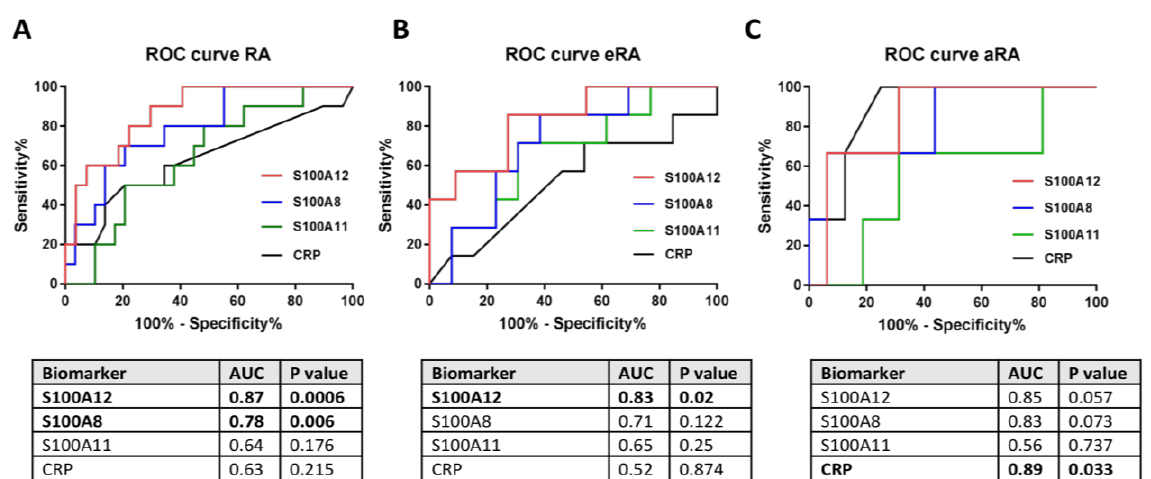
Figure 5. Receiver operating characteristic (ROC) curves for S100A8, S100A11, S100A12, and CRP in the sera of RA patients: ROC analysis comparing S100A12, S100A8, S100A11 proteins in sera vs. CRP levels in all RA patients ( n = 37 – 39) ( A ); ROC analysis comparing S100A12, S100A8, and S100A11 proteins in sera vs. CRP levels in eRA patients ( n = 18 – 20) ( B ); and ROC analysis comparing S100A12, S100A8, and S100A11 proteins in sera vs. CRP levels in aRA patients ( n = 19) ( C ) as biomarkers of high disease activity. AUC: area under the curve.